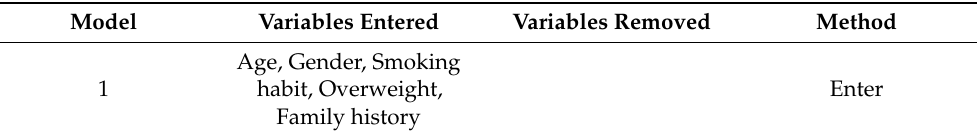
Table 6. Multilinear Regression Test Results/Variables